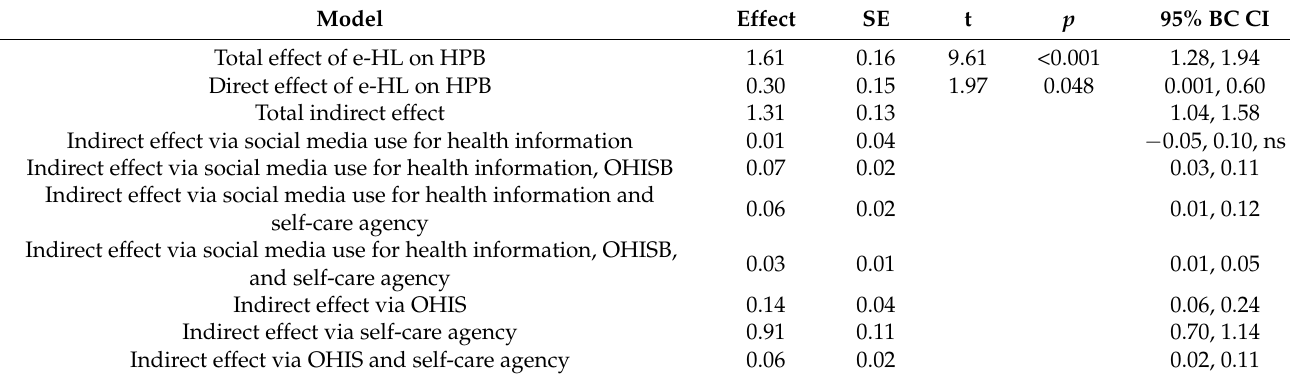
Table 3. Total, direct, and indirect effects in the multiple mediator